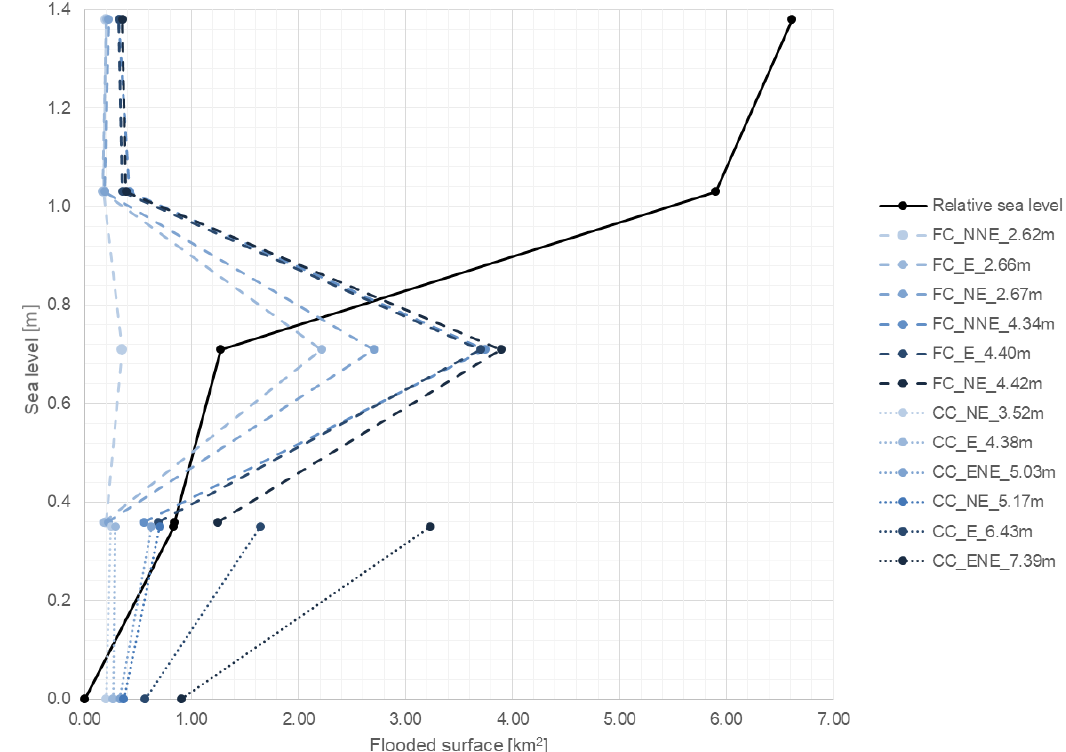
Figure 15. Variation of the flooded area depending on relative sea level and the characteristics of the modelled storm. The solid line shows the static contribution of sea level to the total floodplain, whereas dashed lines indicate the additional contribution of storm impact to the total flood according to each tested combination of wave direction and wave height (legend: [current or future climate] _ [wave direction] _ [significant wave height]).